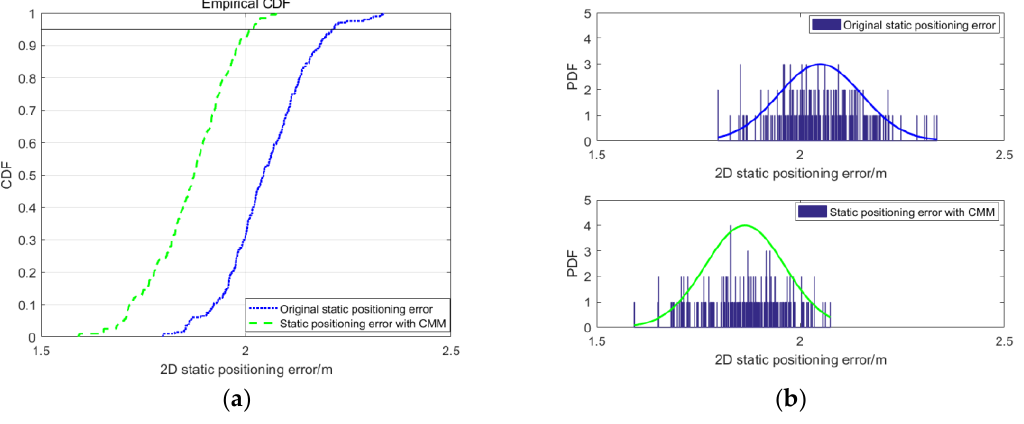
Figure 9. The CDF and PDF of 2D static positioning error. ( a ) CDF; ( b ) PDF.